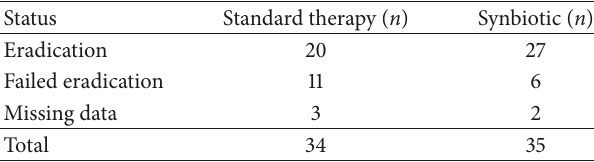
Table 2: The eradication success in study groups.